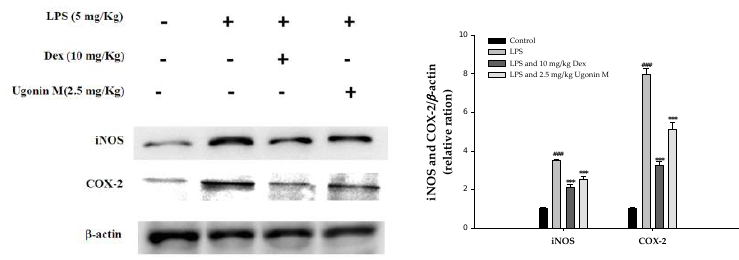
Figure 8. Effects of Ugonin M on iNOs and COX-2 protein expression in lung tissue. Six hours after LPS injection with or without Ugonin M pretreatment, the mice were exsanguinated and their lungs were removed. A representative Western blot from two separate experiments is shown, and its relative protein levels were calculated with reference to a LPS-only group. The data represent the mean ± SD for three different experiments performed in triplicate. ### p < 0.001 was compared with a sample of the control group (One-way ANOVA followed by Scheffe’s multiple range tests). *** p < 0.001 was compared with the LPS-only group.